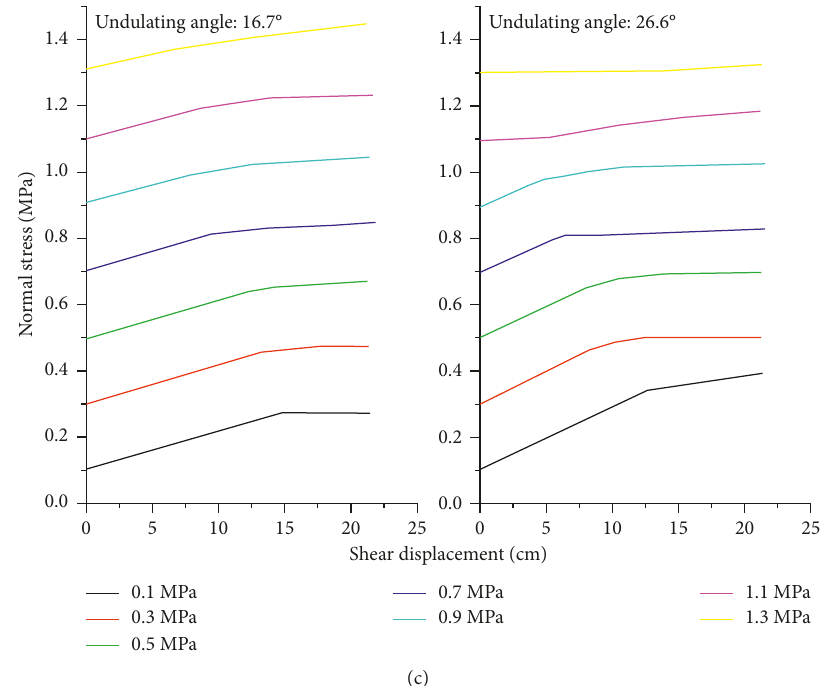
Figure 6: Shearing characteristics curve of the infilled joint with different undulating angles. (a) Shear stress-shear displacement curve. (b) Normal displacement-shear displacement curve. (c) Normal stress-shear displacement curve.